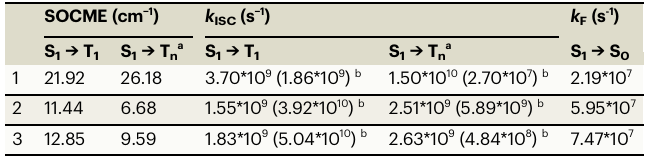
Table 3 | Calculated SOCME (cm − 1 ), ISC rate ( k ISC , s − 1 ), and fl uorescence emission rate ( k metry of 1 – 3 with ω B97X-D3 functional and def2-TZVP(-f) basis